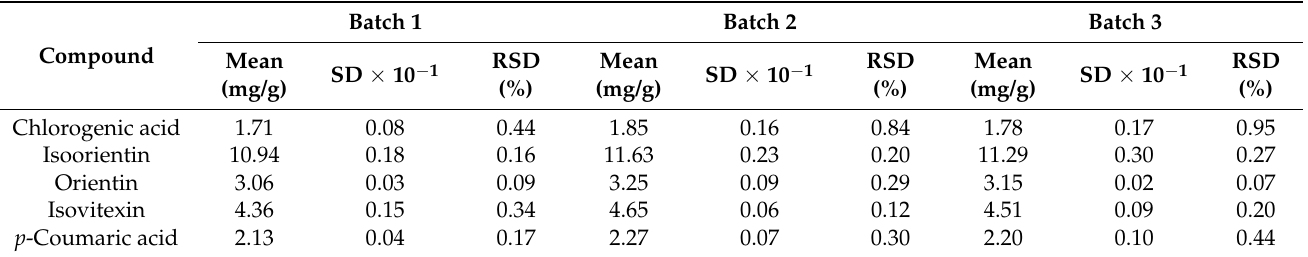
Table 4. Quantitation of the five marker compounds in samples of P. pubescens leaves by HPLC–DAD ( n = 3).